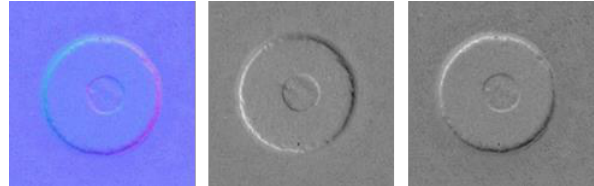
Figure 12. Detail 300x300 pixels of retro target in (left) normals; (centre) X gradients; (right) Y gradients.